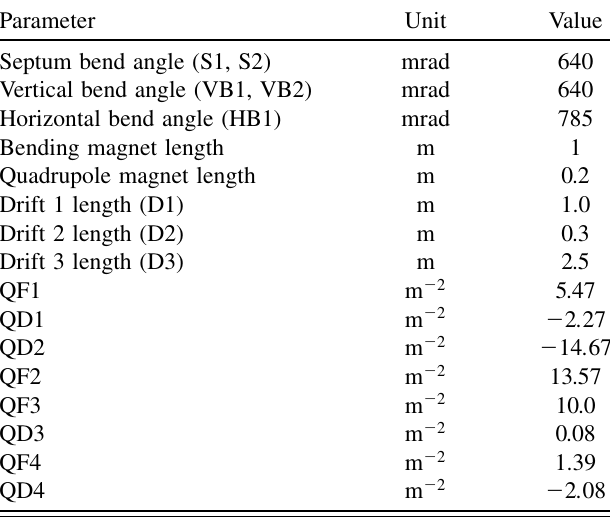
TABLE VI. Proton to carbon ring transfer line parameters. S1, S2, VB1, and VB2 are vertical bends; HB1 is a horizontal bend; all dipoles and all quadrupoles are of the same length; QF (QD) are focusing (defocusing) in the horizontal plane, and there are four different quadrupole doublets in the transfer